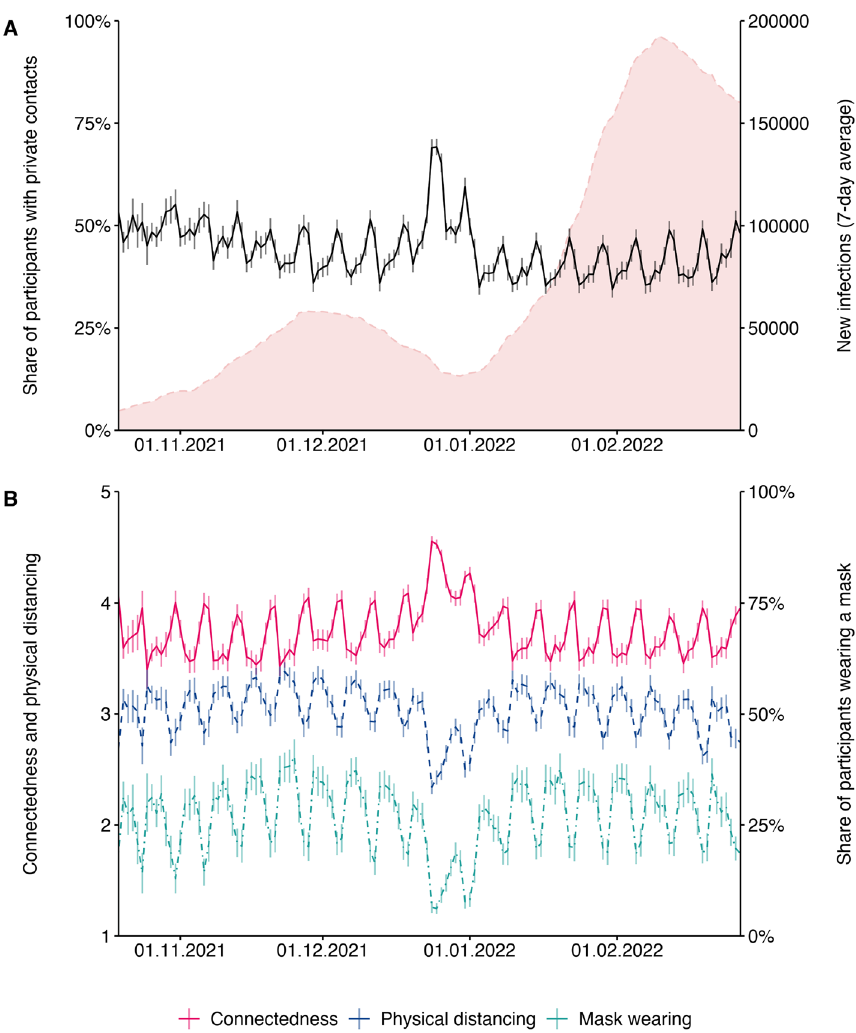
Figure 2. Covariation of connectedness towards others, physical distancing, and mask wearing. Note : ( A ) Between October 2021 and February 2022, the share of participants indicating to have private contacts outside their own household slightly decreased as the number of infections increased. ( B ) For participants who reported having had private contacts during the last day, perceived connectedness, and protective behaviours during the meetups (physical distancing and mask wearing) were negatively correlated. On weekends and over the holiday season at the end of 2021, private contacts were more likely, connectedness was higher, and protective behaviours were shown less than on weekdays and outside the holiday season. Translucent vertical bars indicate 95% confidence intervals. While connectedness and physical distancing were measures on a 5-point scale